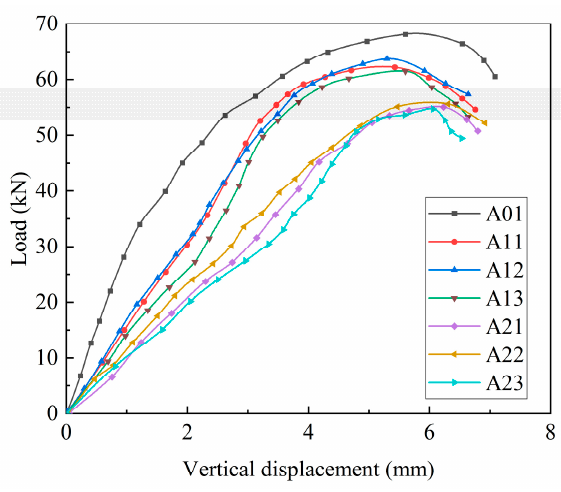
Figure 12. Load–vertical displacement curves of the corroded steel beams.